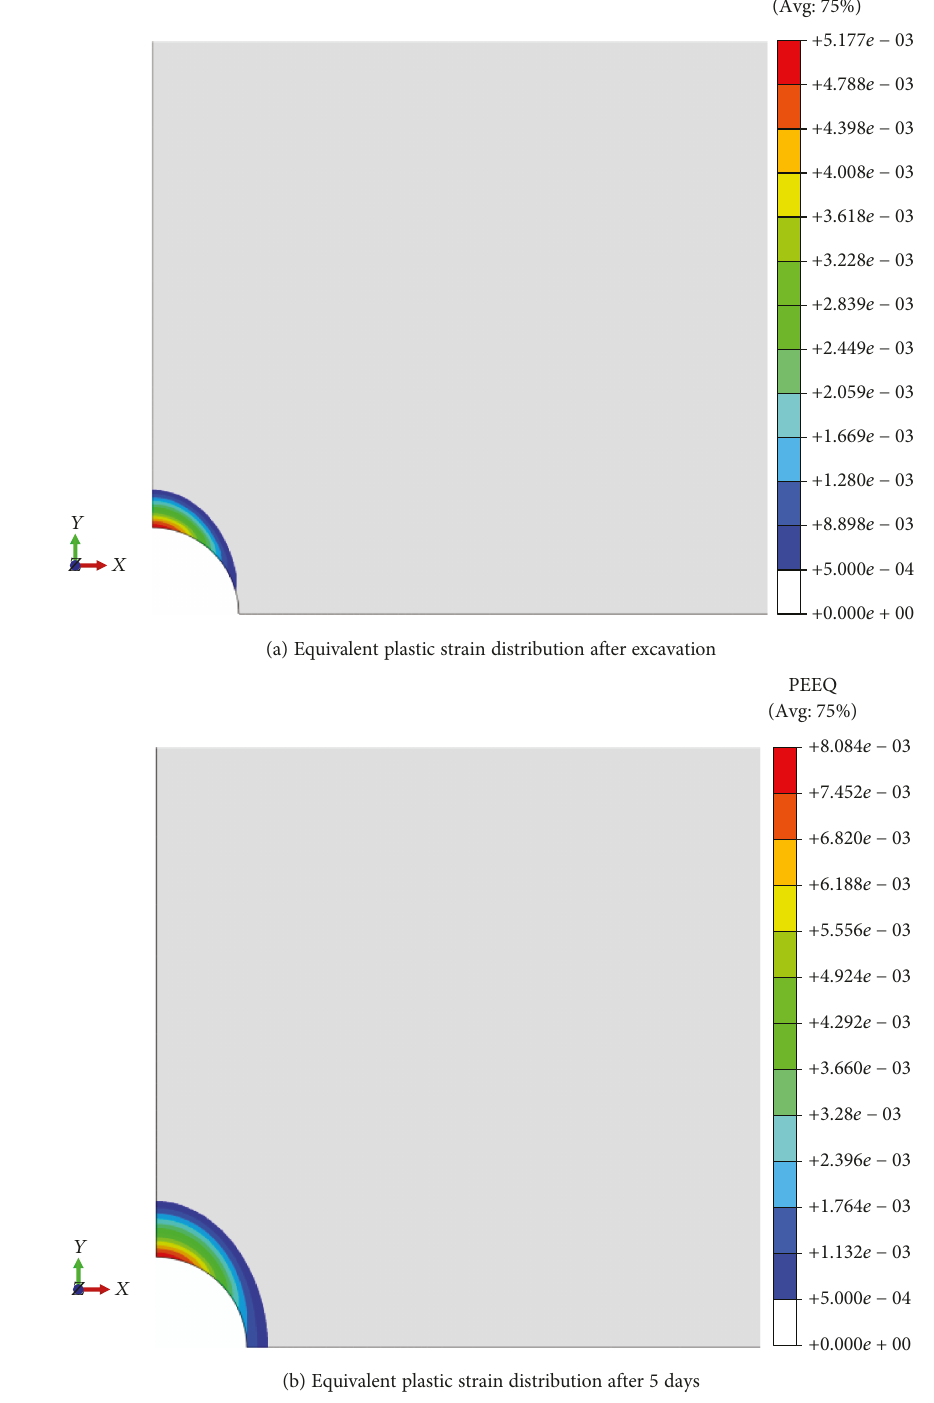
Figure 14: Progressive failure process of the wellbore with a drilling fl uid density of